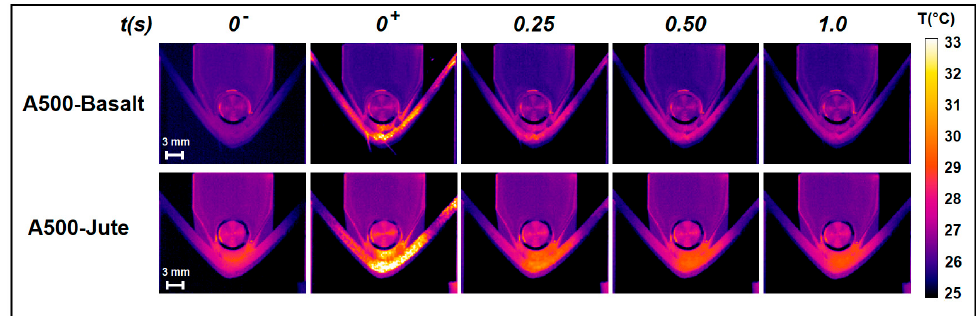
Figure 4. Thermal images extrapolated at di ff erent time from the sequences recorded for the two specimens A500-Basalt ( fi rst row) and A500-Jute (second row): the last frame before the pulse ( t = 0 − ), the fi rst unsaturated frame after the pulse ( t = 0 + ), and the frames acquired after 0.25 s, 0.50 s, and 1.0 s from time t = 0 + .